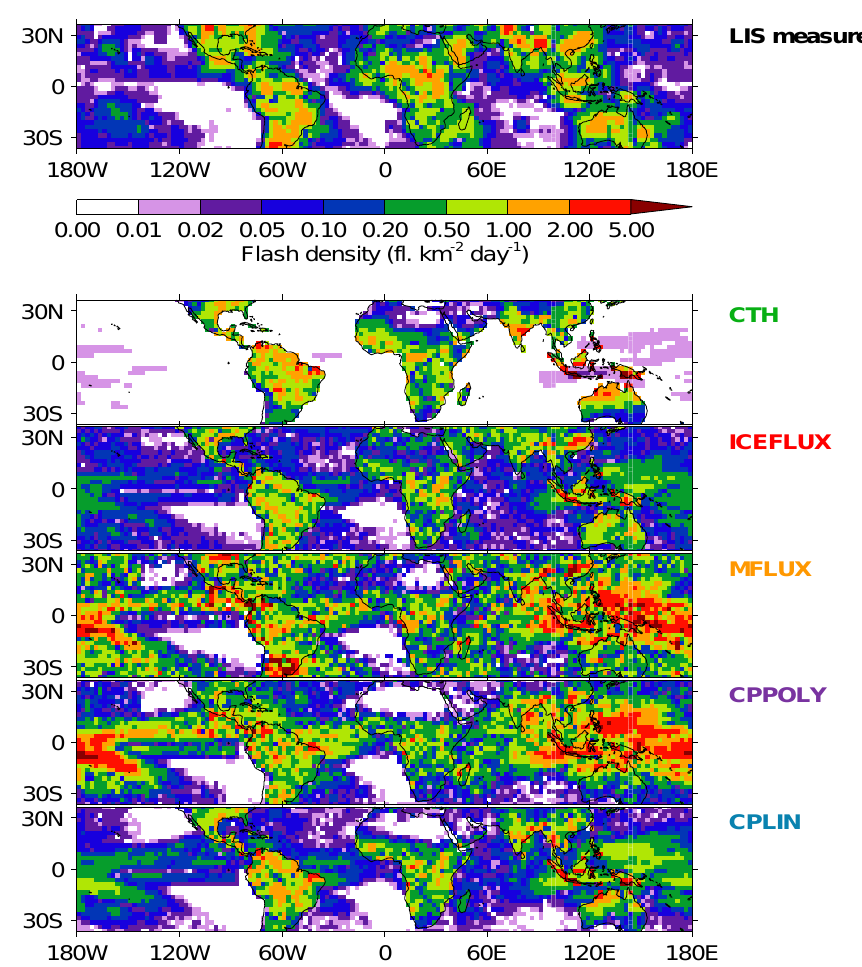
Figure 10. Five year climatological interannual peak-to-peak difference spatial distribution of flash density for 2007–2011. The interannual peak-to-peak difference has been calculated as the average difference between consecutive years over the five year period. Results are shown for the LIS measurements and the five